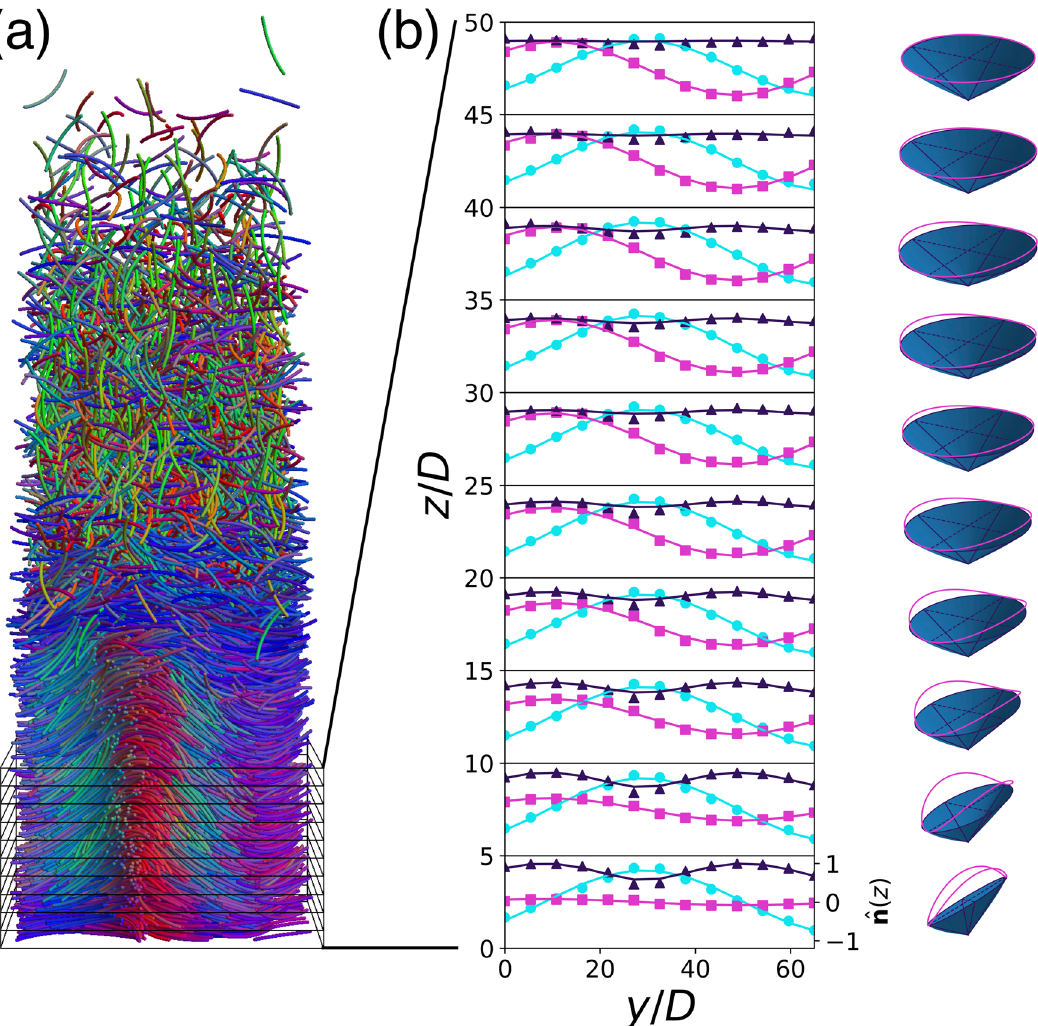
Fig. 5 A system of curved rods in gravity. a Typical con fi guration from a simulation on a system of hard curved spherocylinders with an aspect ratio L / D = 19 and central angle Ψ = 0.99 in a gravitational fi eld along (cid:2) ^ z with a gravitational length l = 7.5 D and a hard wall at z = 0. The phase sequence I-N-N g TB - Sm TSB -Sm SB is observed from the top to the bottom in the sediment. b The x -, y -, and z -components of the nematic director fi eld ^ n ð y Þ ¼ ð n x ð y Þ ; n y ð y Þ ; n z ð y ÞÞ in subsequent slabs of the system of thickness 5 D , showing a continuous transition from splay-bend deformations to twist-bend deformations with increasing altitude z , corresponding to lower pressure and density. The measured values of the nematic director fi eld are denoted by the varying symbols, whereas the lines denote a fi t of the simulation data using Eq. (3). The precession cones correspond to the fi ts of the nematic director fi eld, showing a continuous transition from an N TB phase with a director fi eld precessing around a circular cone at the top of the sediment, via an Sm TSB phase where the precession cone becomes elliptic, towards an Sm SB phase where the elliptical cone reduces to a fl at triangle at the bottom of the sample. Source data for ( b ) are provided as a Source Data fi